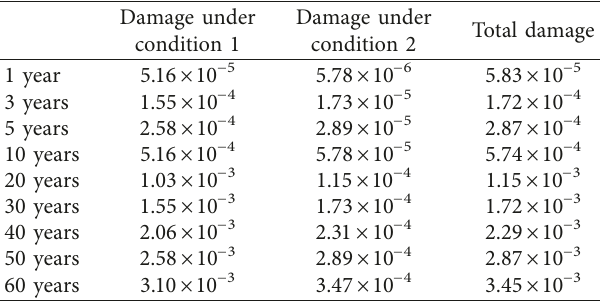
Table 11: Damage of the bed plate under temperature load after different service